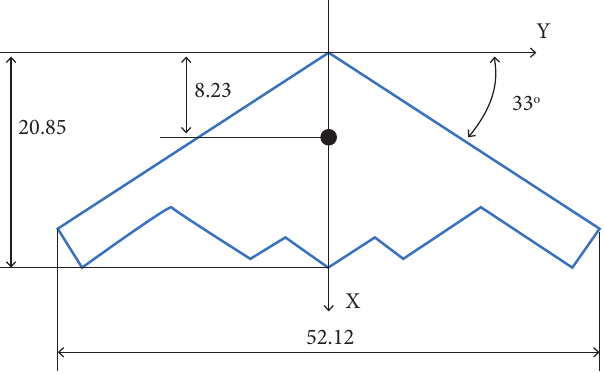
Figure 4. Configuration of the high-aspect-ratio UAV (m).